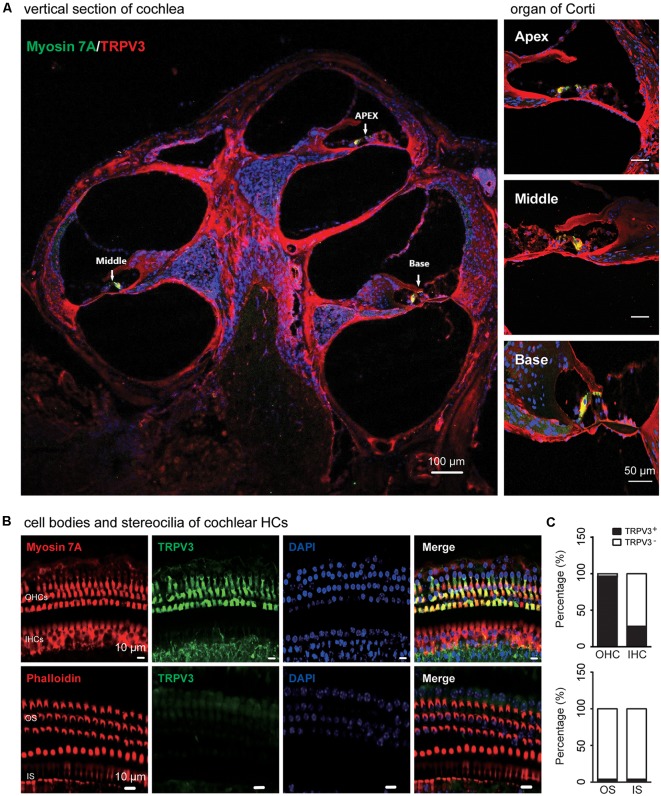
Immunolabeling of transient receptor potential cation channel, vanilloid type (TRPV) 3 in the cochlea of mice. (A) Representative images of TRPV3 expression (red) in cochlear sections are shown (left panel). The apex, middle, and base of the cochlea (arrow) are expanded from the left panel and presented in the upper, middle, and bottom-right panels, respectively. Cell bodies (myosin 7A, green) and cell nuclei 4′,6-diamidino-2-phenylindole (DAPI, blue) of hair cells (HCs) are labeled. Scale bars = 100 μm (left panels) and 50 μm (right panels). (B) Immunolabeling of TRPV3 (green) in cell bodies (myosin 7A, red) and stereocilia (phalloidin, red) of HCs in cochlear preparations; cell nuclei are stained with DAPI (blue). Scale bars = 10 μm. (C) Percentage of TRPV3-positive (TRPV3+, solid bar) and -negative (TRPV3−, open bar) HCs (upper panels), and percentage of TRPV3-positive and -negative stereocilia (bottom panels) in cochlear preparations.